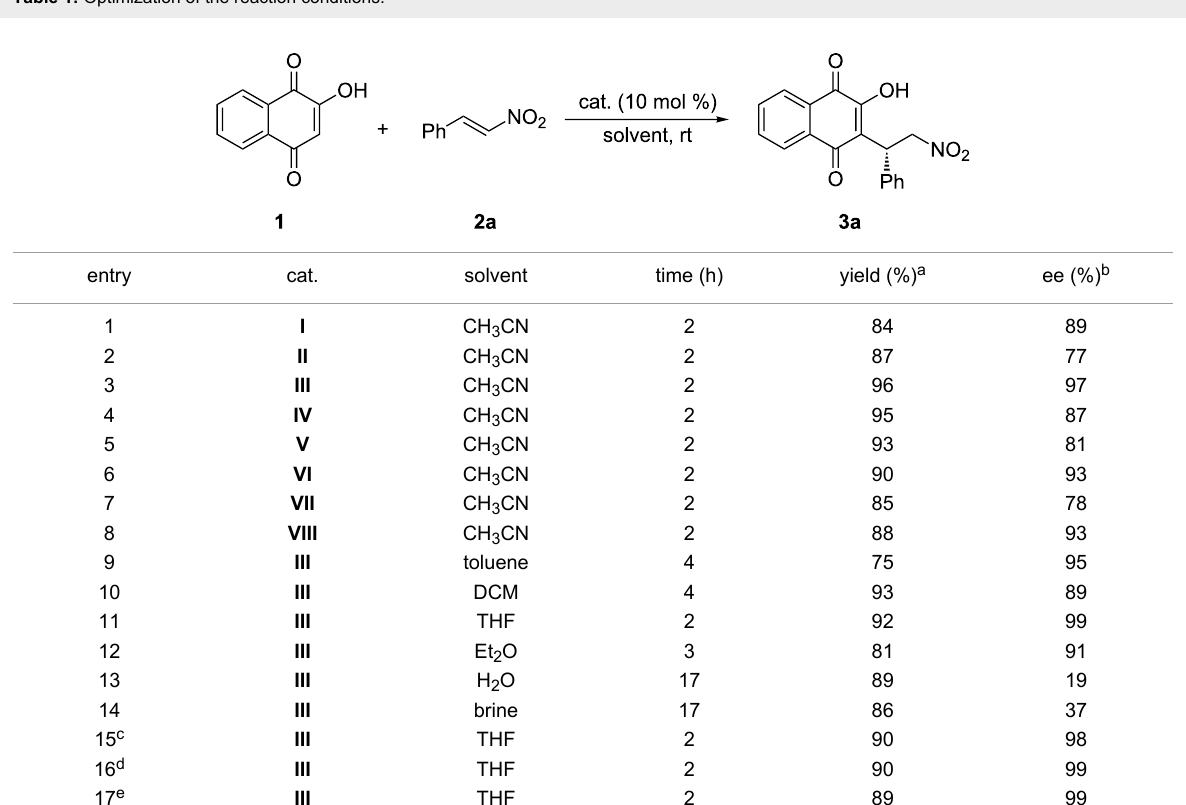
Table 1: Optimization of the reaction